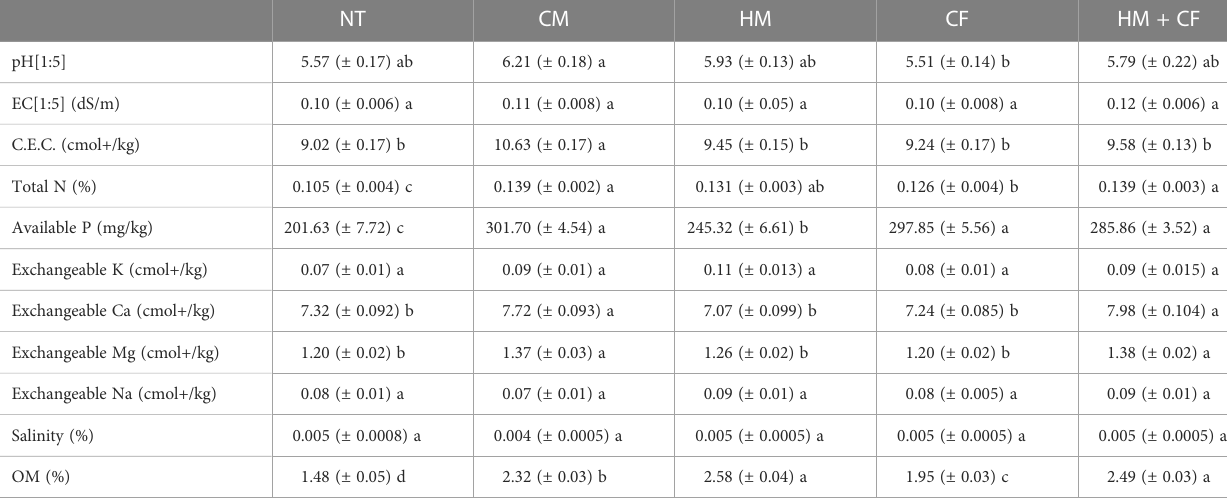
TABLE 1 Chemical components of fertilizers remaining in the